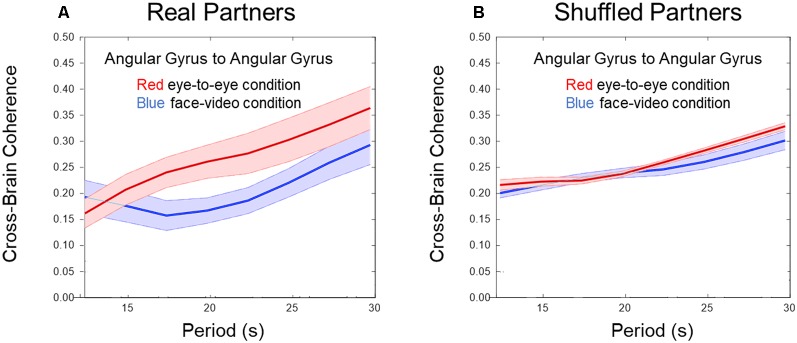
Cross-brain coherence. (A) Angular gyrus (AG) cross-brain coherence between paired dyads during direct eye-to-eye contact (red trace) shows increased coherence in the combined DeOxy+OxyHb signals for periods between 15 and 25 s compared to the face video condition (blue trace; p 0.01, N = 15 pairs). (B) Shuffled dyads do not show differences in cross-brain synchrony in the AG when comparing face-to-face or video face interactions.